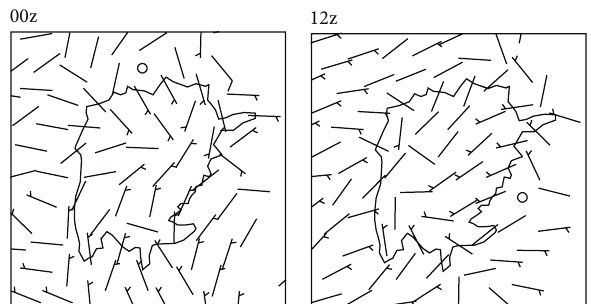
Figure8:Vectorwindsoverthelakeat00zand12zontheNovember 22 at the 850 hPa pressure level. Wind speed represented using wind barbs in